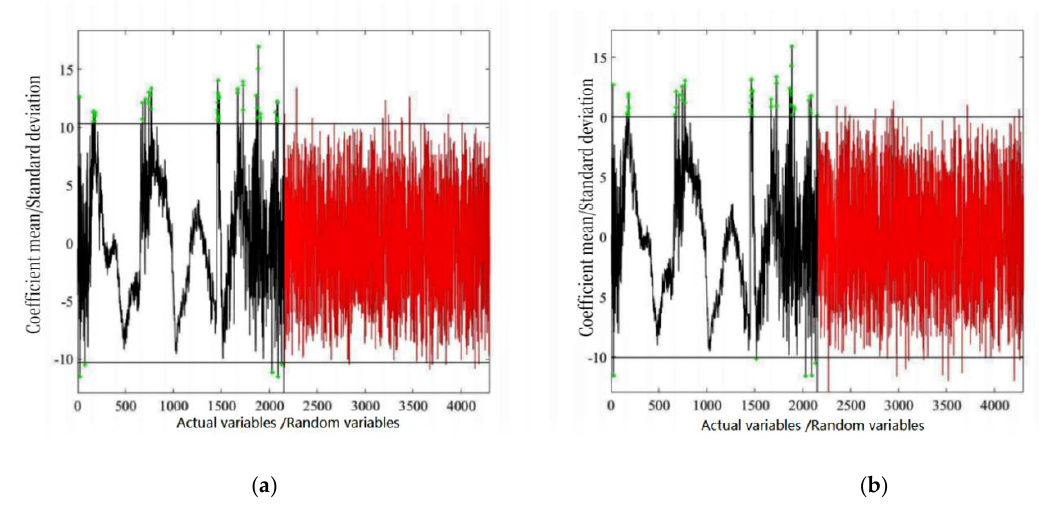
Figure 6. Band screening results of SOM content VIS-NIRS based on UVE. ( a ) Variable combination of S-G-SNV pretreated spectra screened by UVE and ( b ) variable combination of S-G-MSC pretreated spectra screened by UVE. Table 4. PLS modeling of soil organic matter content with different